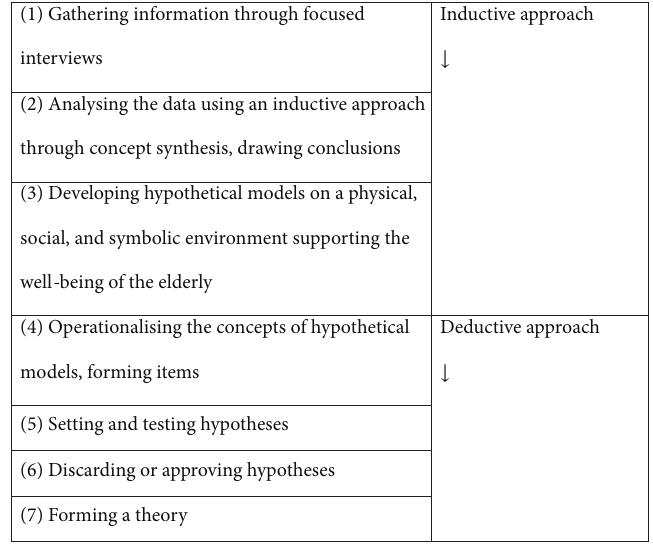
Figure 1: The phases of forming a theory, adapted from Lauri & Kyng¨as 2005